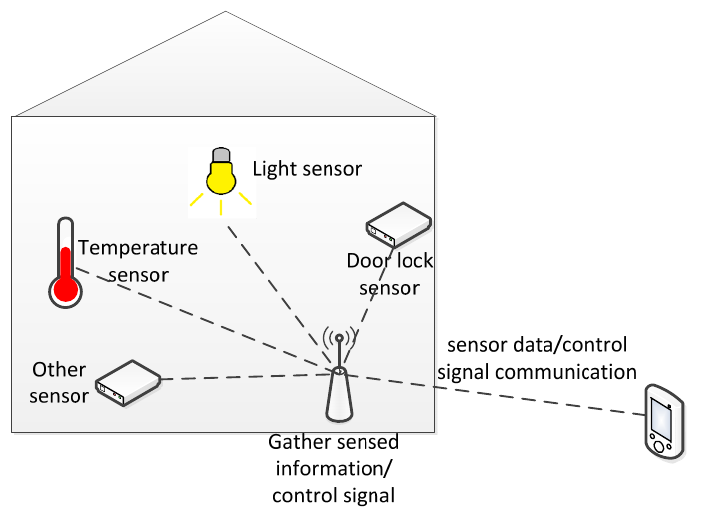
Figure 6. One of IEEE 802.11ba scenarios: the smart home.